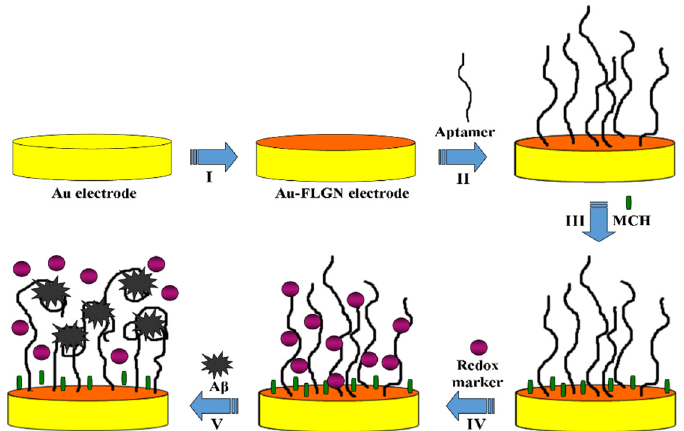
Figure 2. The scheme of fabrication of the aptasensor and A β detection: I—electrode position of FLGN, II—aptamer immobilization, III—MCH immobilization, IV—A β incubation. Adapted with permission from Ref. [114].